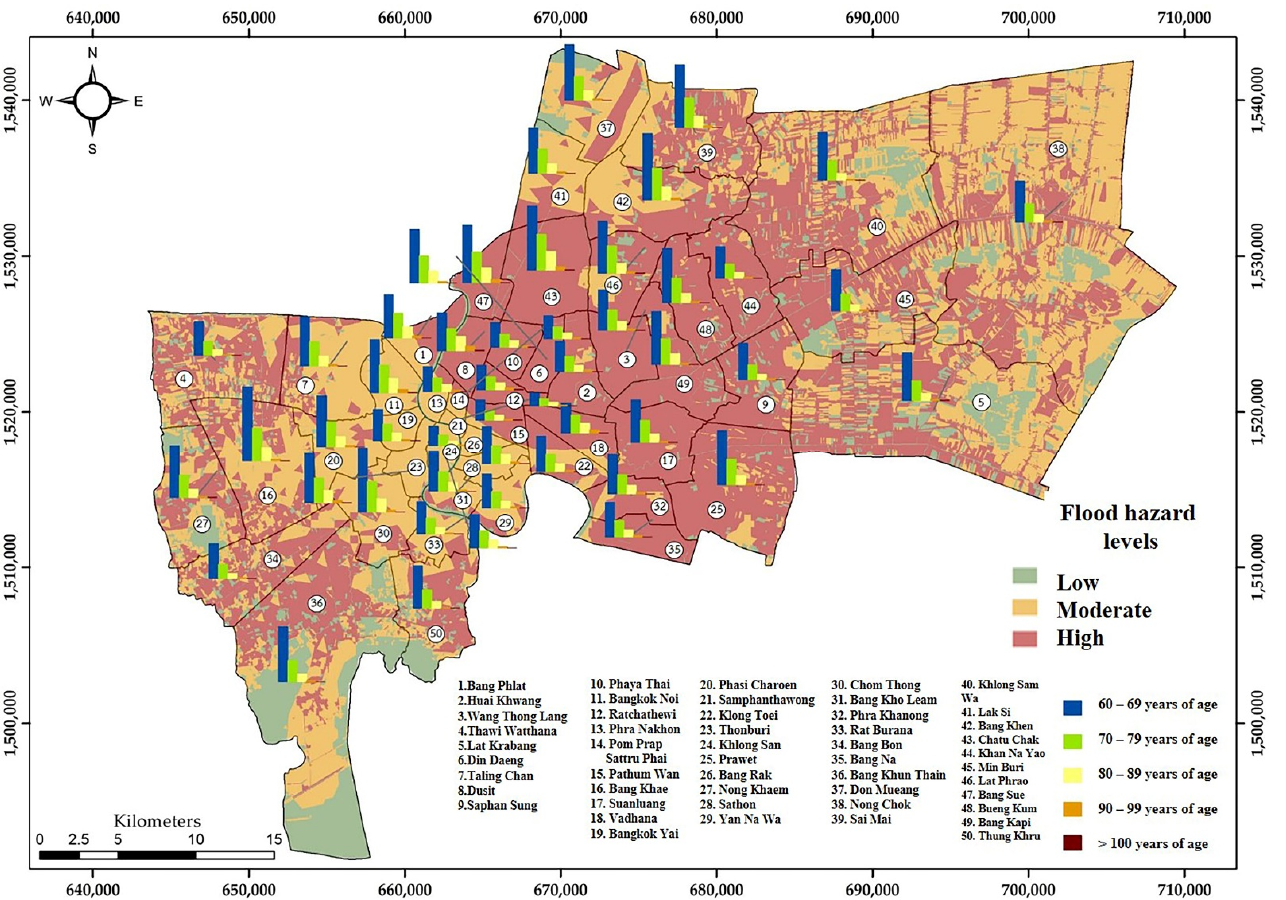
Figure 4. Number of the elderly residing in flood hazard areas of Bangkok,